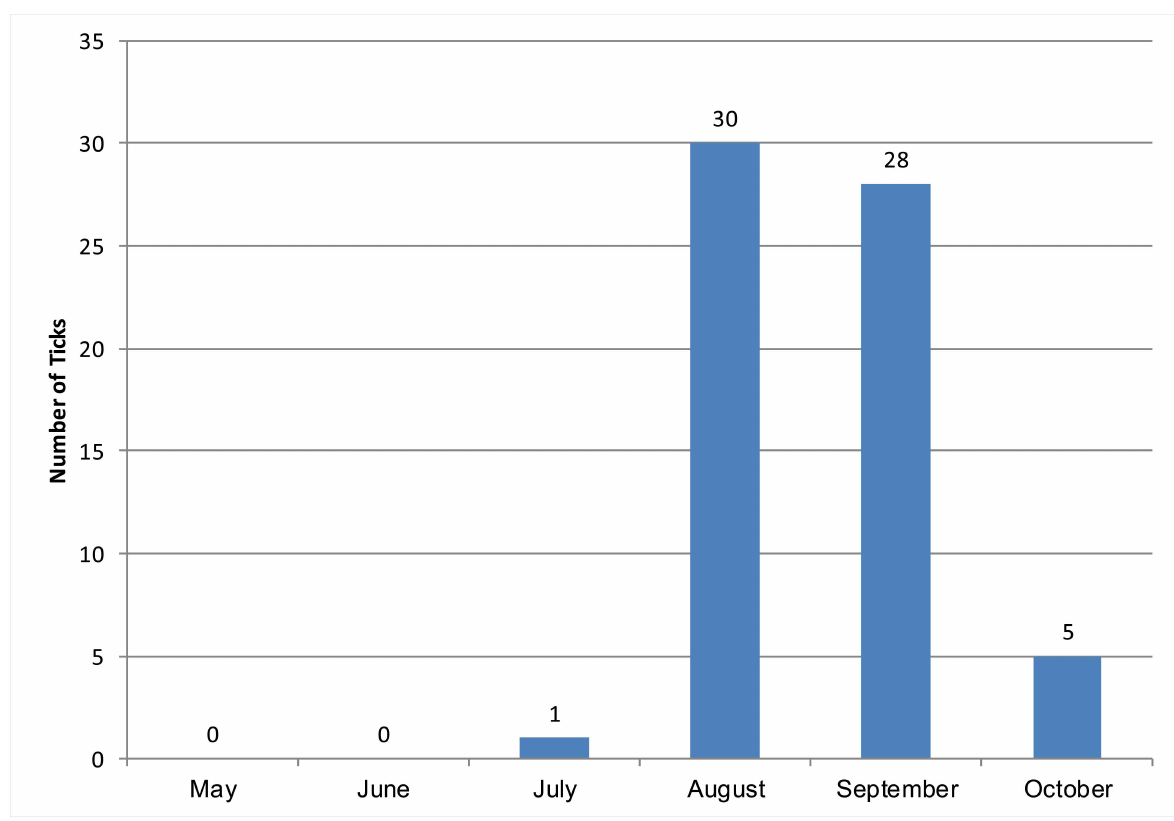
Fig 4. Number of nymphal D . occidentalis collected biweekly at Jack London State Park, Sonoma County, California, May- October,